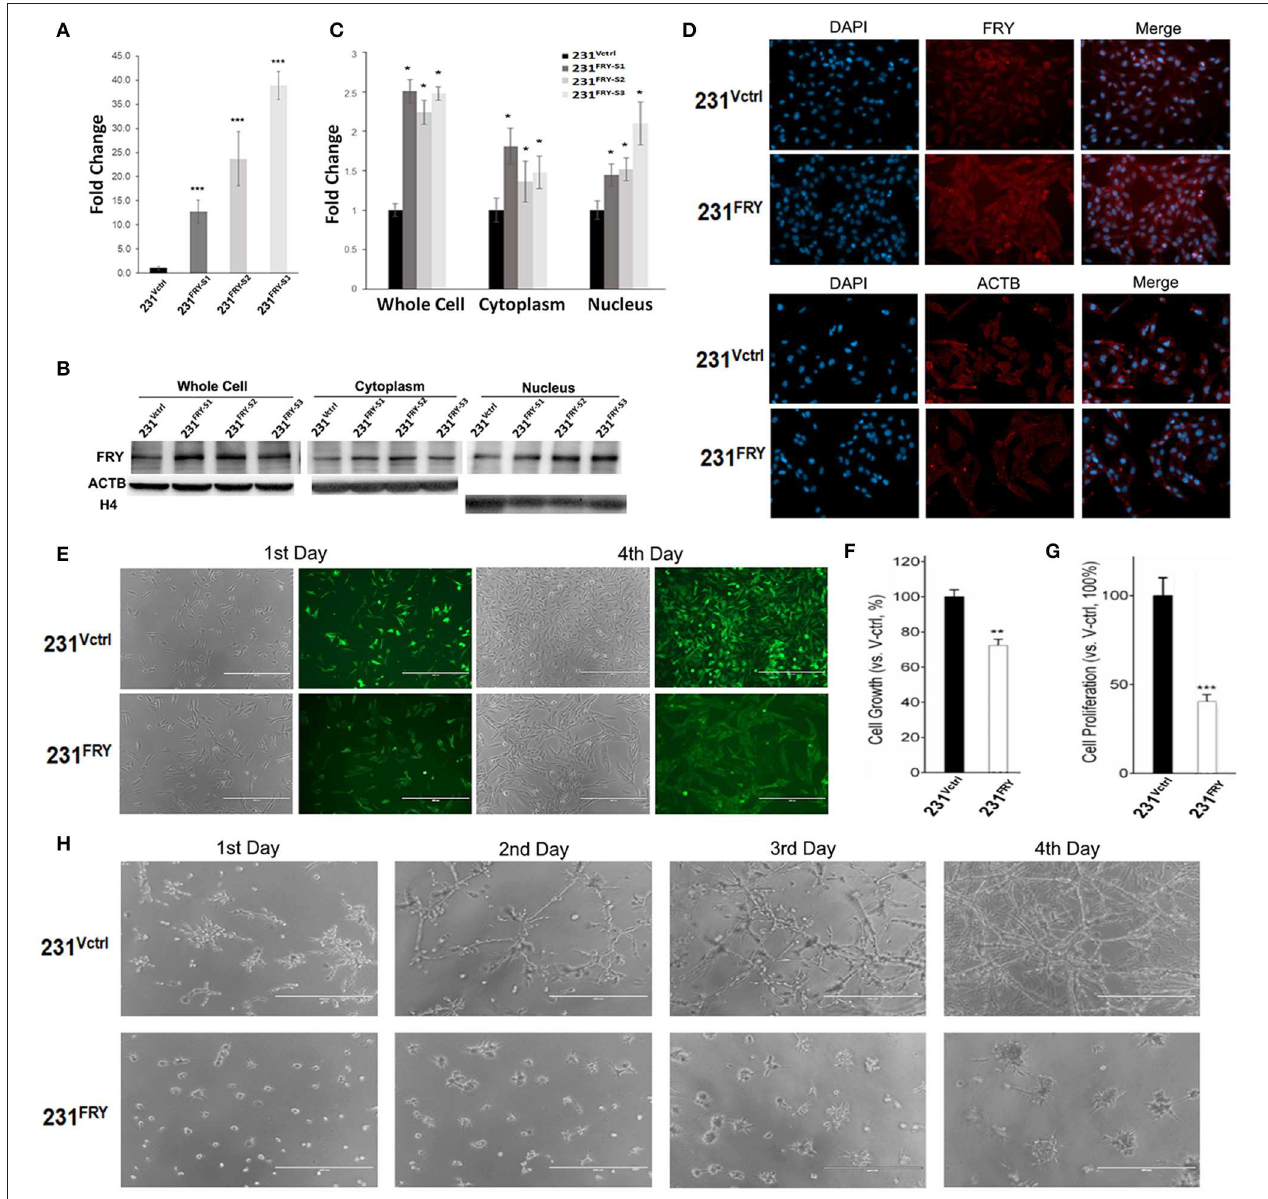
FIGURE 4 | Ectopic expression of Fry changes breast cancer cell morphology and suppresses growth and proliferation of breast cancer cell lines. (A) FRY mRNA levels in established 231 Vctrl and 231 FRY cells. (B,C) A representative Western blot analysis shows the increased ectopic FRY protein levels in MDA-MB-231 human breast cancer cell line. Quantification of FRY level was performed by normalization to ACTB levels. (D) FRY and ACTB protein levels in 231 Vctrl and 231 FRY cells measured by cell immunofluorescence analysis ( nuclei stained with DAPI). (E) Changed morphologies of MDA-MB-231 breast cancer cell lines in monolayer culture with the expression of FRY . (F,G) Cell growth and proliferation of 24h were evaluated with MTT assay and BrdU assay. (H) The morphologies of 231 Vctrl and 231 FRY cells in three-dimensional Matrigel culture. Results are representative of three independent experiments. Bars represent the mean ± SEM of three independent experiments. Statistical significance: * P < 0.05; ** P < 0.01; *** P <